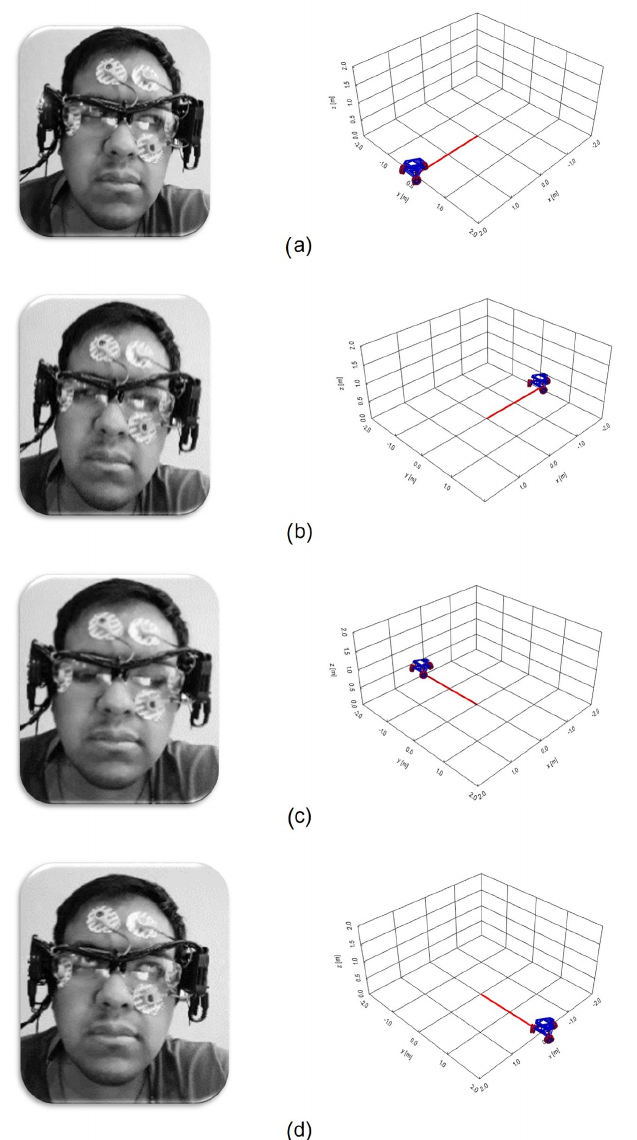
Figure 23. Virtual robot movements when controlled by the rotation of the eyeball. ( a ) Eye movement looking up and tracking the robot’s trajectory forward. ( b ) Eye movement looking down and tracking the robot’s trajectory backwards. ( c ) Eye movement looking to the right and tracking the robot’s trajectory to the right. ( d ) Eye movement looking to the left and tracking the robot’s trajectory to the left. Figure 24 indicates the monitoring of the desired values indicated in the state machine for each control variable µ x , µ y representing the linear velocity in meters per second and w B representing the angular velocity in radians per